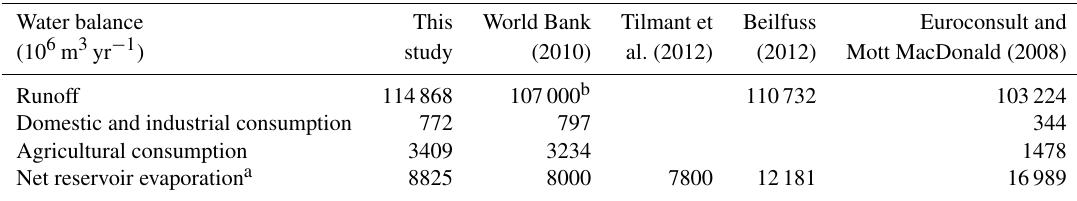
Table 5. Water balance of the reference scenario. Results are presented as the average for the 40-year simulation. The amount of runoff and reservoir evaporation varies significantly depending on the studies. Average yearly runoff might be influenced by the historical period considered.